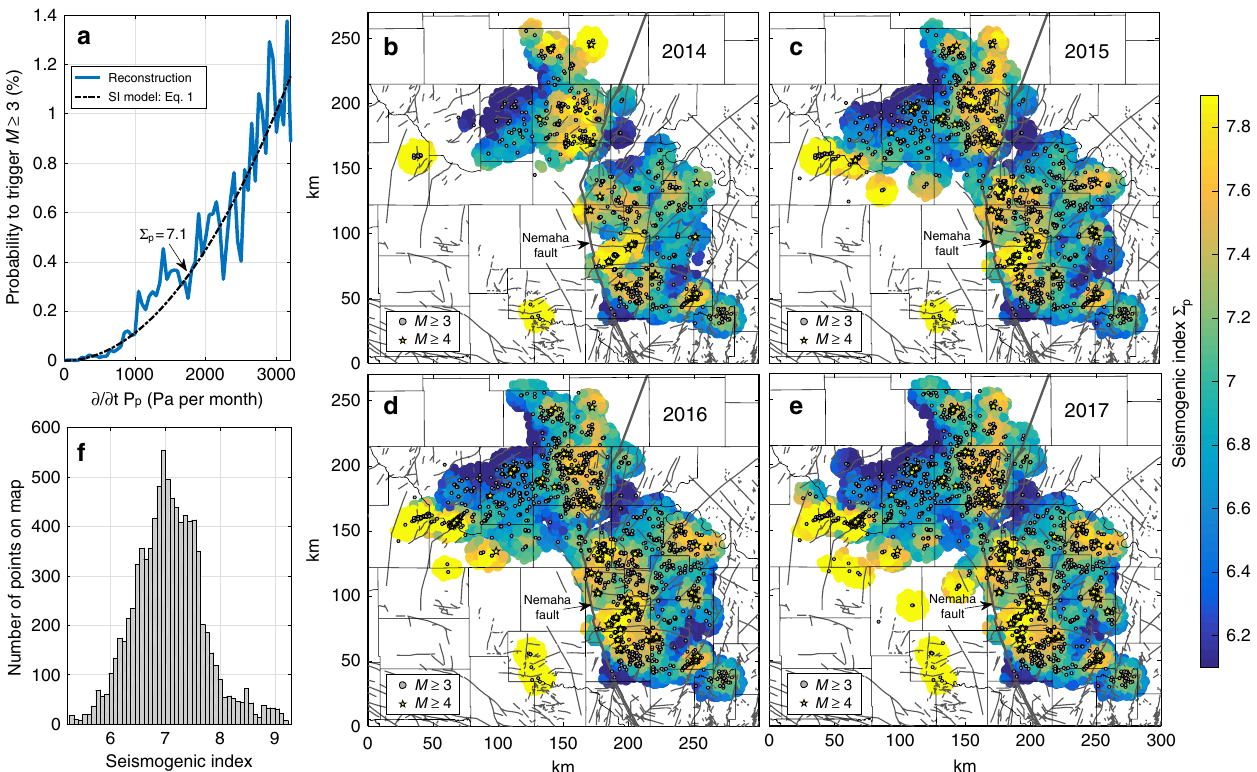
Fig. 2 Reconstructed earthquake-triggering probability ( M ≥ 3), seismogenic index maps and histogram of spatial SI fl uctuations. a Reconstructed probability to trigger an M ≥ 3 earthquake at a given pressure rate in our model (see Methods for details). The reconstruction is based on observed earthquakes and modelled pressure rates through Dec 2017 in the complete study area. The probability increases with the square of the pressure rate and a SI of 7.1 (see Eq. 1). b – e Mapped spatial variability of the SI in north-central Oklahoma and southern Kansas. The SI has been computed in local-scale regions of 10-km radius around the 25,000 seed points and is calibrated through different temporal endpoints between December 2014 and December 2017. The SI shows signi fi cant variability in space but it is stable in time. Regions of high and low SI can already be differentiated using earthquakes through Dec 2014 for calibration. More details on the calibration of the SI can be found in the Methods section. f Histogram of the calibrated SI shown on the map in panel e . The mapped SI fl uctuates around a mean value of about